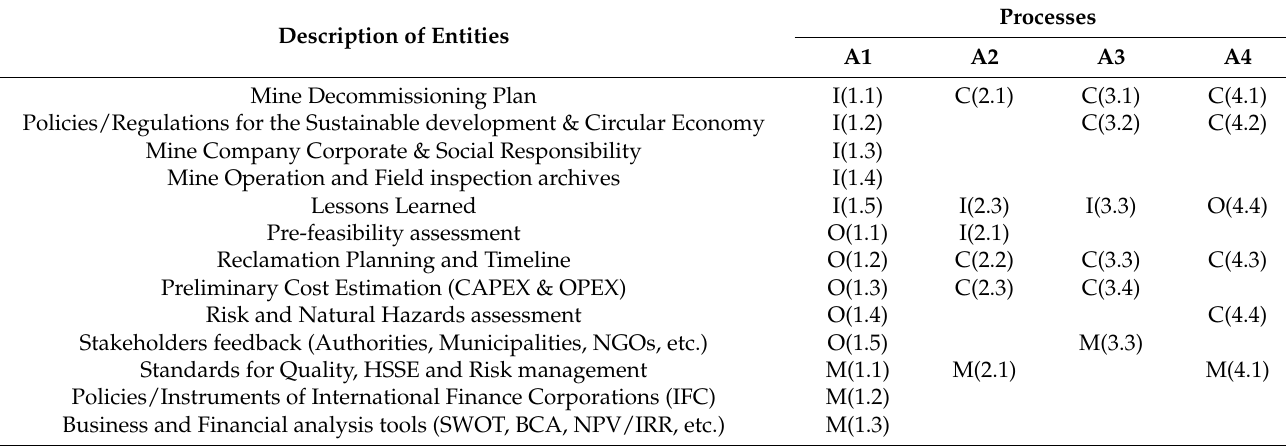
Table 2. ICOM Entities: Inputs, Controls, Outputs,